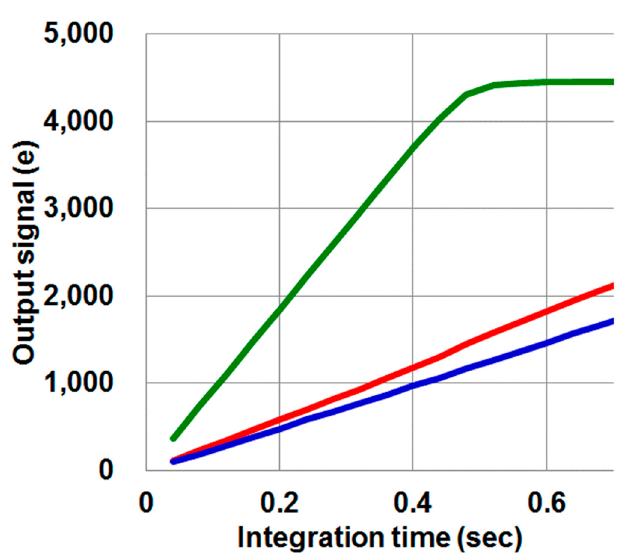
Figure 12. Light response curve of the 0.9 µm pixel.